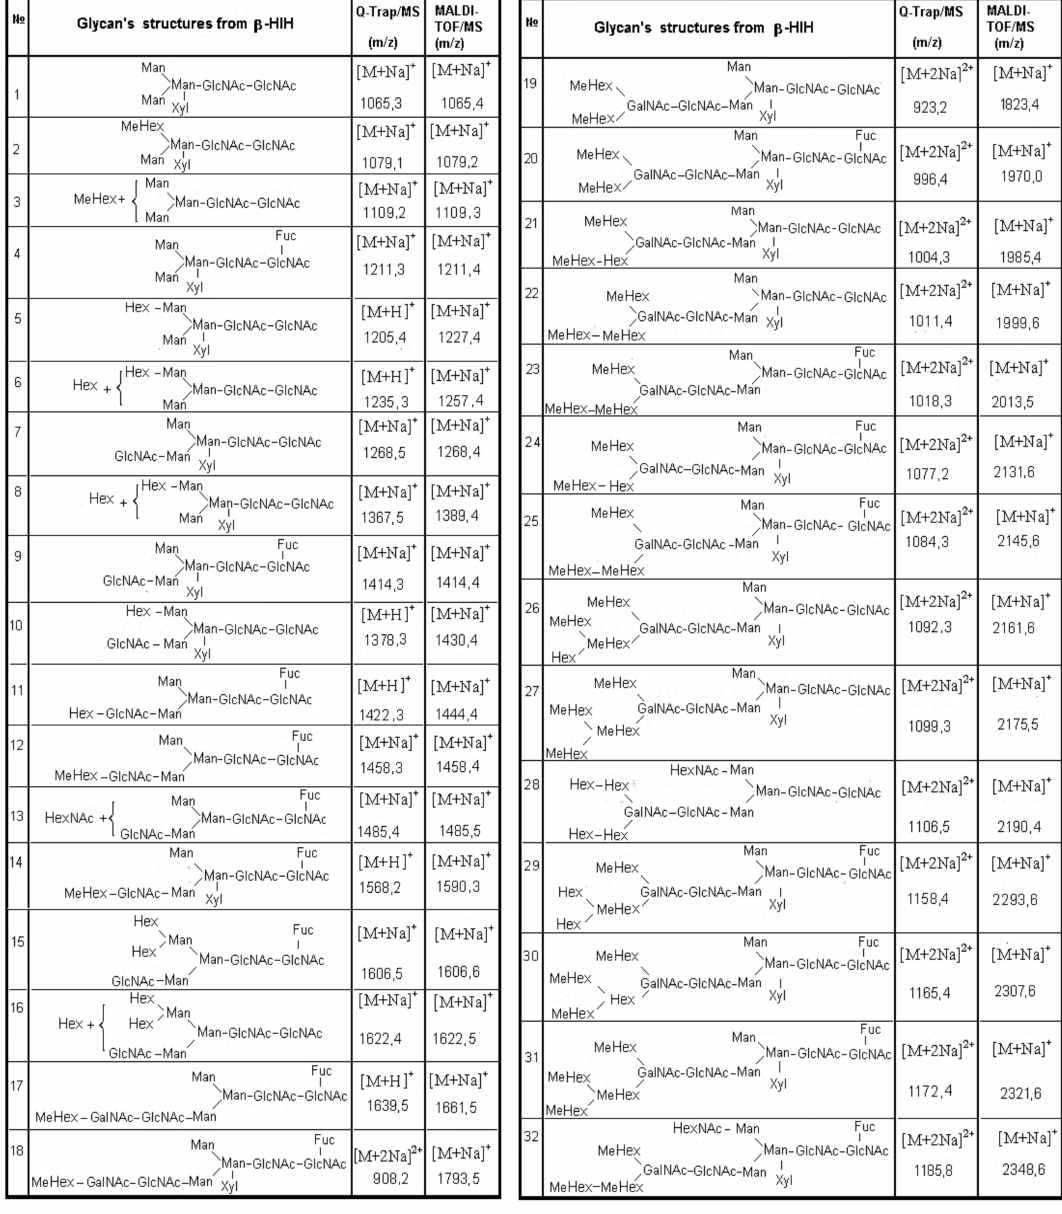
Figure 11. Structures of glycans from β -HlH, determined through di ff erent methods